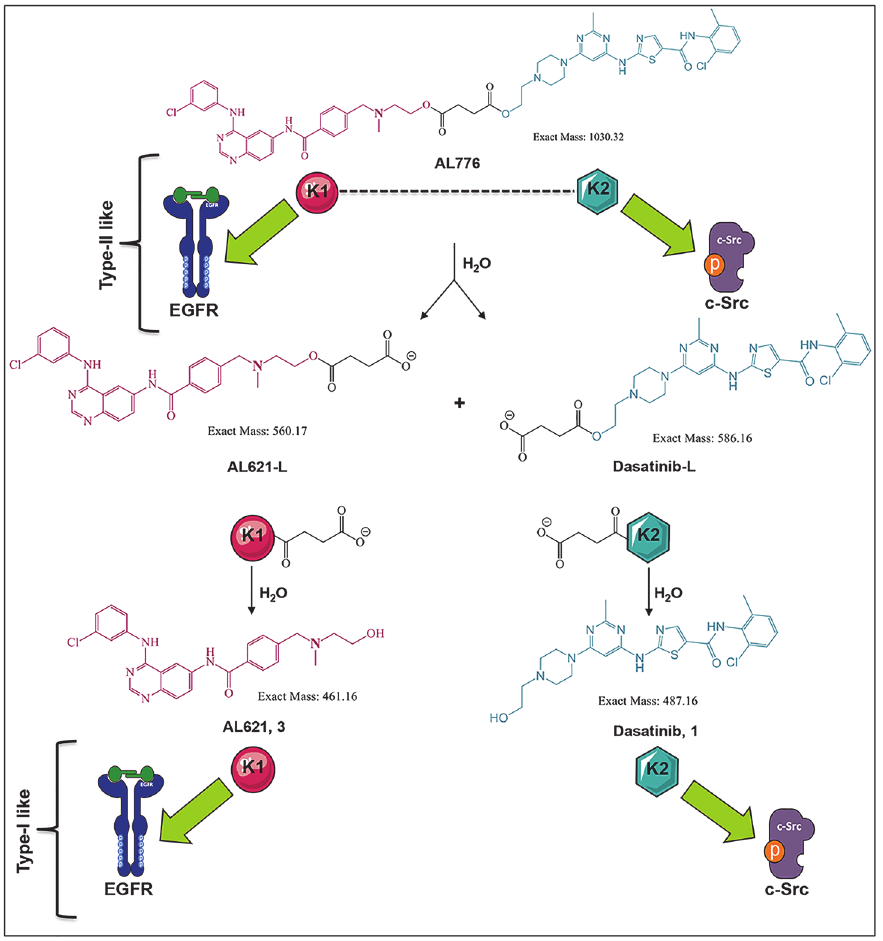
Fig 5. Schematic representation of AL776 hydrolysis and its hydrolyzed metabolites. Based on LC-MS characterization of the metabolites of AL776 both in vitro and in vivo , the hydrolytic scheme of AL776 is modified to represent all the major metabolites. The K1-K2 molecule undergoes hydrolysis to generate the acidic forms of AL621 and dasatinib (AL621-L and dasatinib-L), which are further metabolized to AL621 (K1 or EGFR inhibitor) and dasatinib (K2 or c-Src